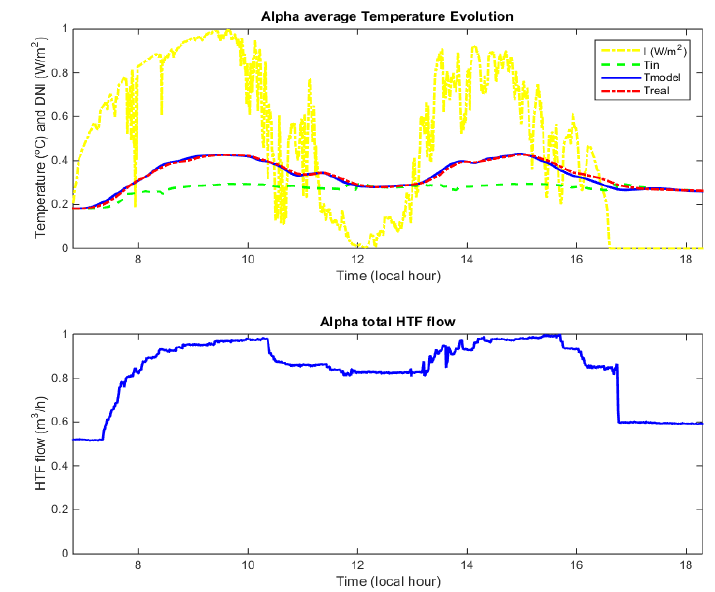
Figure 9. Alpha average temperature, model vs. real evolution: ( top ) model (blue solid) and real (red dash-dotted); and ( bottom ) HTF